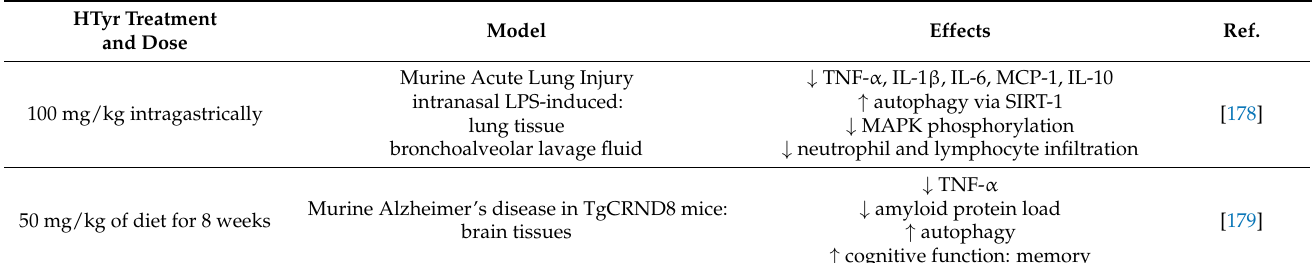
Table 4. In vivo effects of HTyr on